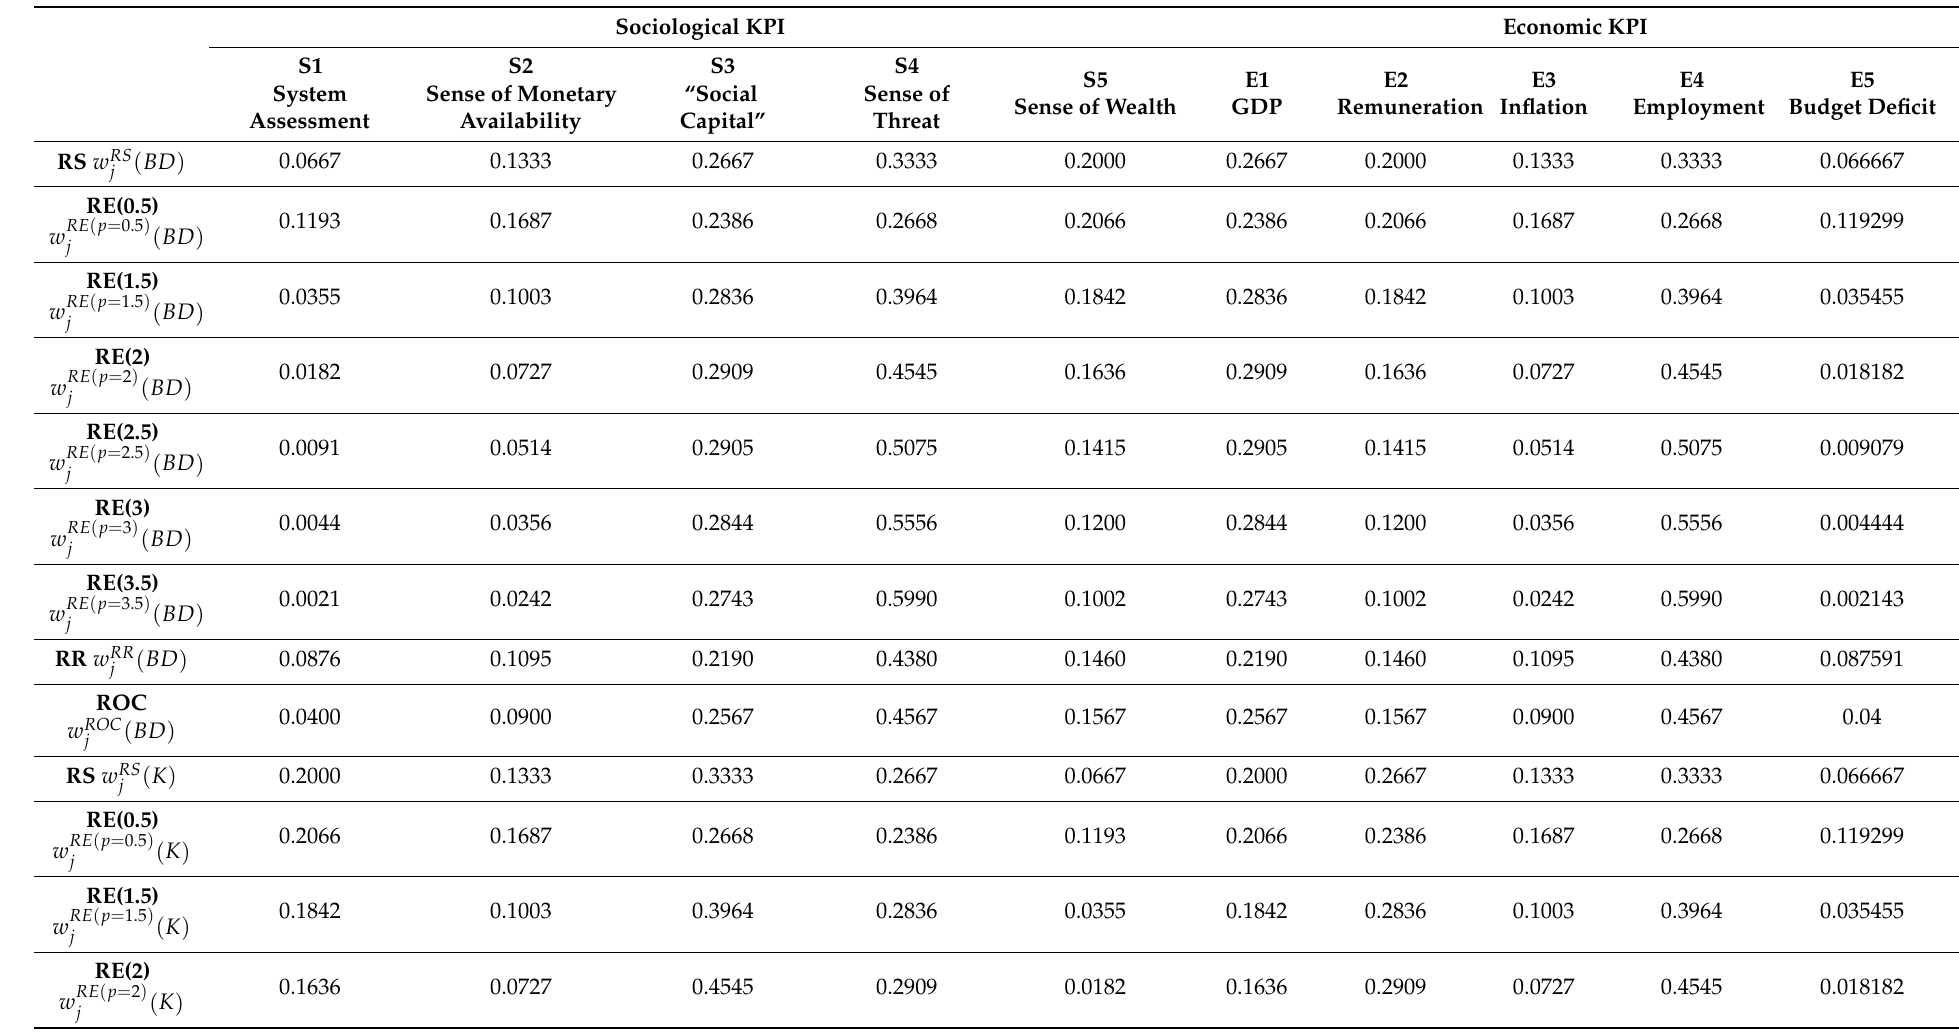
Table 5. Weights of KPI